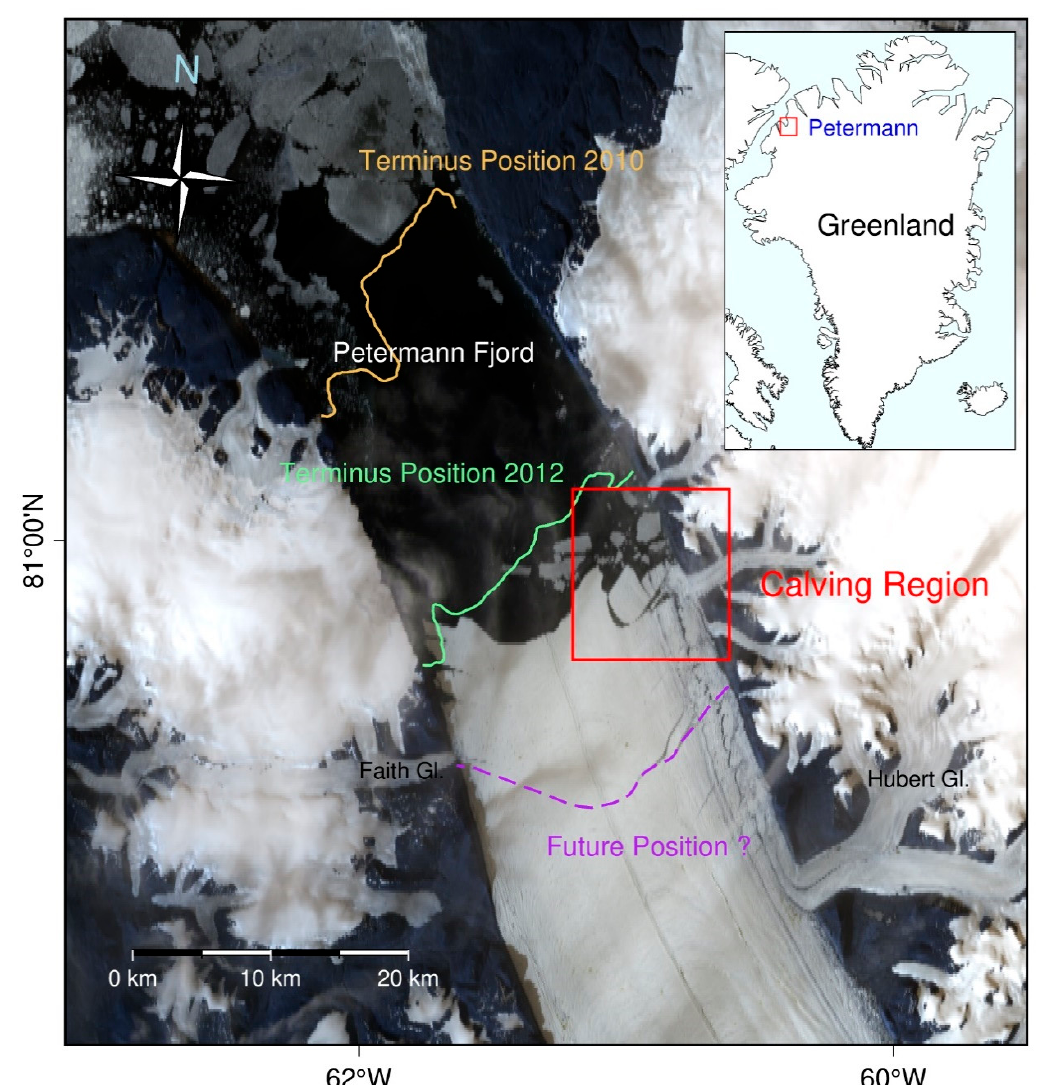
Figure 1. Overview of study map in the Petermann Glacier frontal collapse in 2017. The background image is from a composite of visible-band Landsat 8 scene for 26 July 2017. The light brown and green line illustrate the ice fronts of 2010 and 2012 calving events. The purple line represents a newly developing fracture, from the eastern margin to the center of the ice tongue, marking a forthcoming calving event [38].